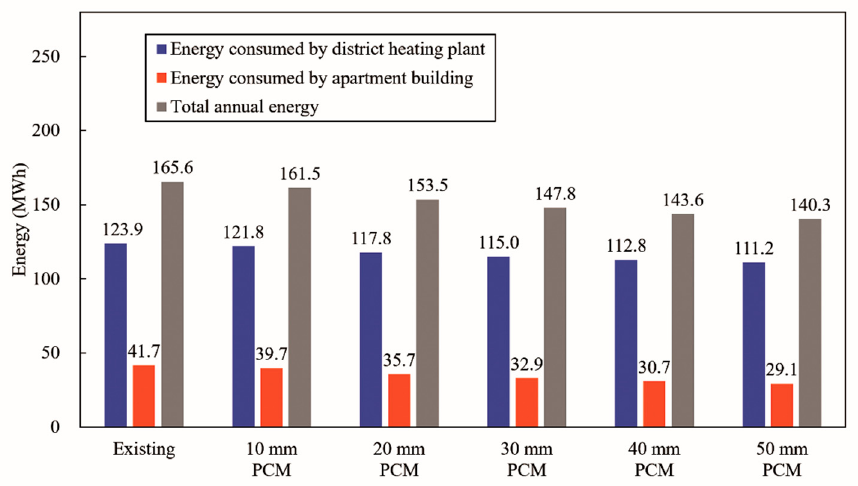
Figure 14. Energy consumptions by the application of 10–50 mm PCM. 306